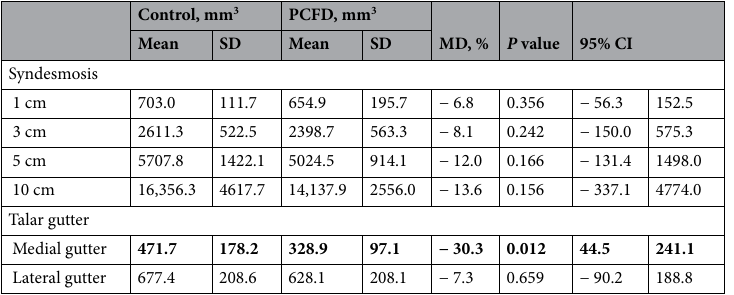
aspect of the gutters. Conversely, there were significant increases in the articular coverage of all three posterior tibiotalar joint zones (average increases of 41.5%, 32.7% and 29.3%, and p-values of 0.009, 0.009, and 0.032 for